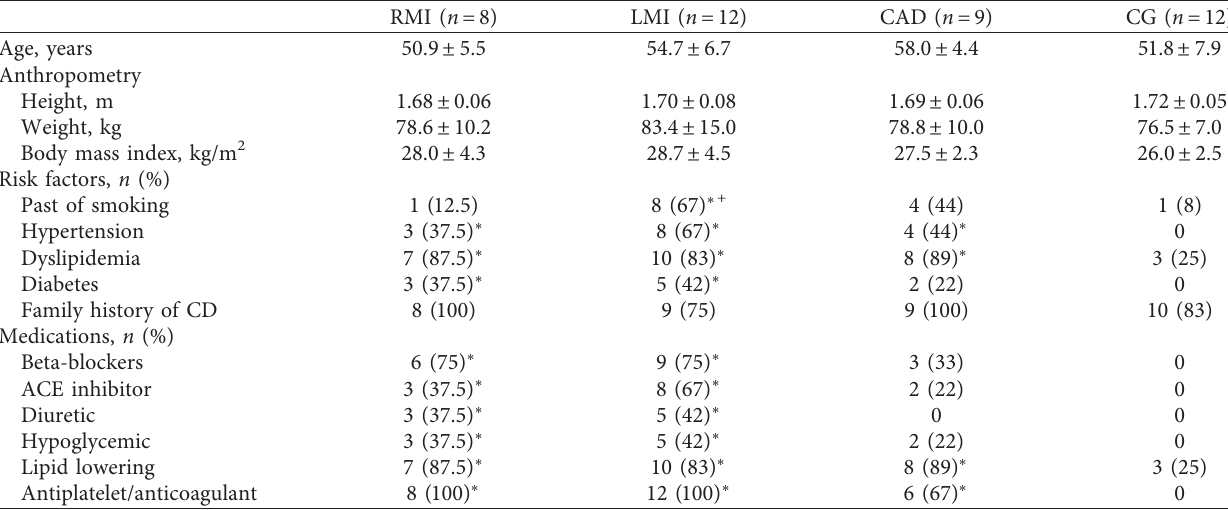
Figure 1: Flowchart showing subjects’ participation in the study. n, number of individuals; BMI, body mass index; RMI, recent myocardial infarction group; LMI, late myocardial infarction group; CAD, stable coronary artery disease group; CG, control group. Table 1: Age, anthropometry, risk factors, and medications of all